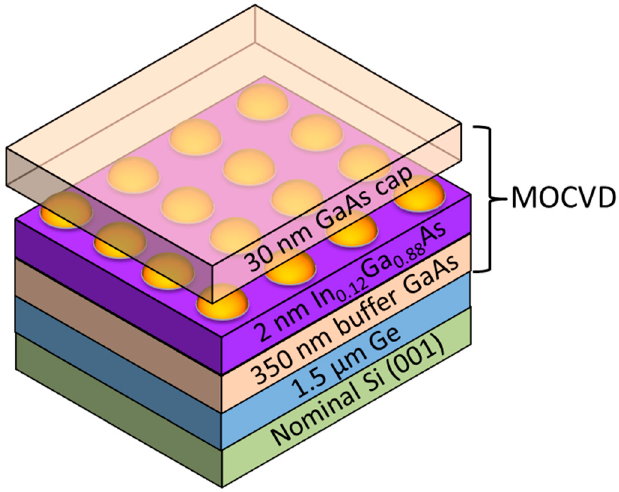
Figure 1. InAs/GaAs quantum dot structure grown on Ge on quasi ‐ nominal Silicon(001)